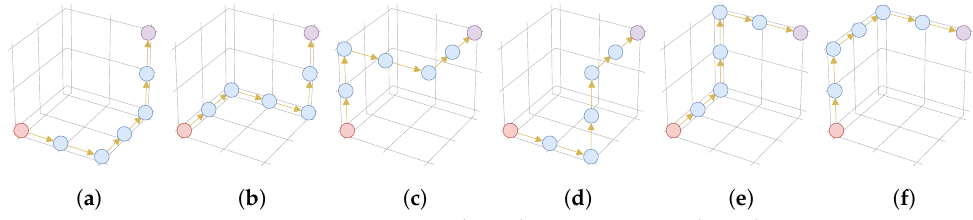
Figure 5. Illustration of the paths from unit ( 1,1,1 ) (in red) to unit ( 3,3,3 ) (in purple) with the 6 permutations of the broadcast mechanisms. ( a ) XYZ . ( b ) YXZ . ( c ) ZXY . ( d ) XZY . ( e ) YZX . ( f ) ZYX